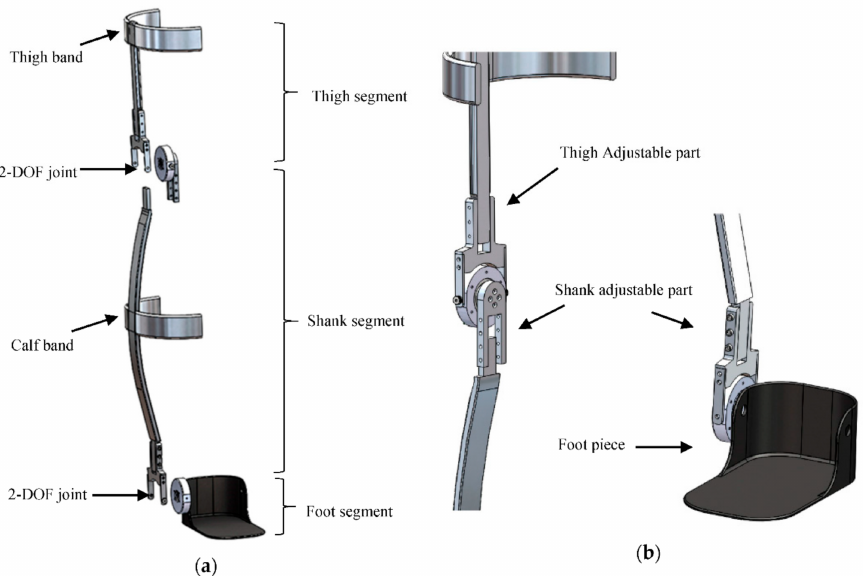
Figure 1. ( a ) Exploded view of 2-Degree-of-Freedom (DOF) joints of the Measurement exoskeleton system (developed for right leg [17]; ( b ) Detailed view height adjustment mechanism